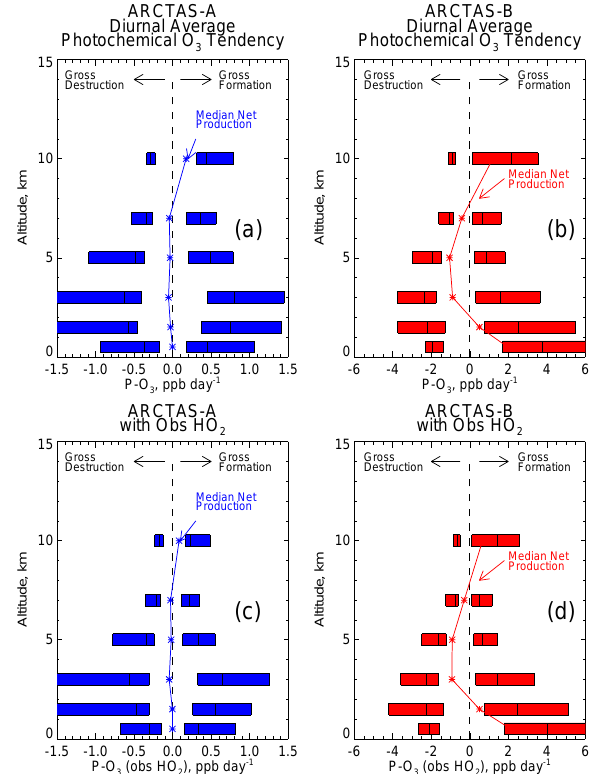
Fig. 21. Altitude profiles of diurnally averaged model calculated gross formation and destruction and net production of O 3 during (a) ARCTAS-A and (b) ARCTAS-B. Bar plots are as described in Fig. 2. Panels (c) and (d) are for the diurnally averaged gross forma- tion and destruction and net production of O 3 using observed HO 2 rather than model